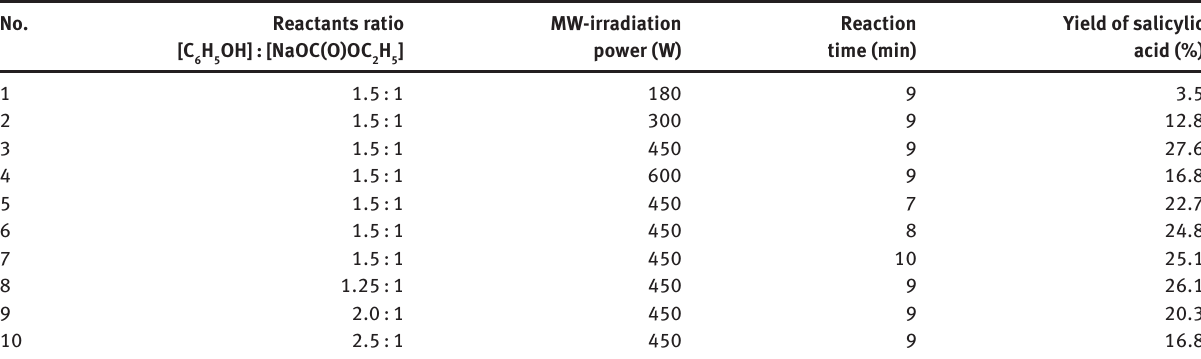
Table 2: Carboxylation of phenol with sodium ethyl carbonate under MW irradiation.